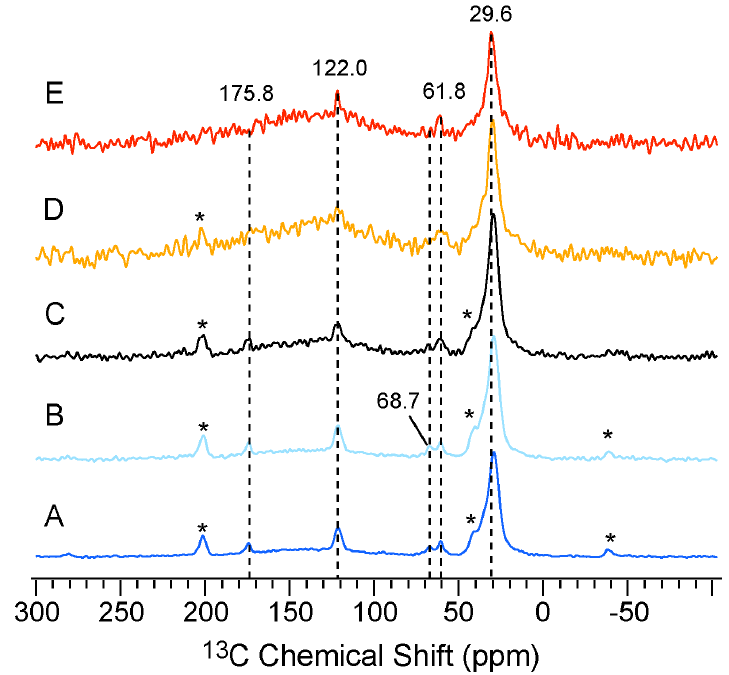
Figure 3. 13 C CP/MAS NMR spectra of NPBA at five different temperatures: ( A ) 298 K; ( B ) 318 K; ( C ) 333 K; ( D ) 353 K and ( E ) 363